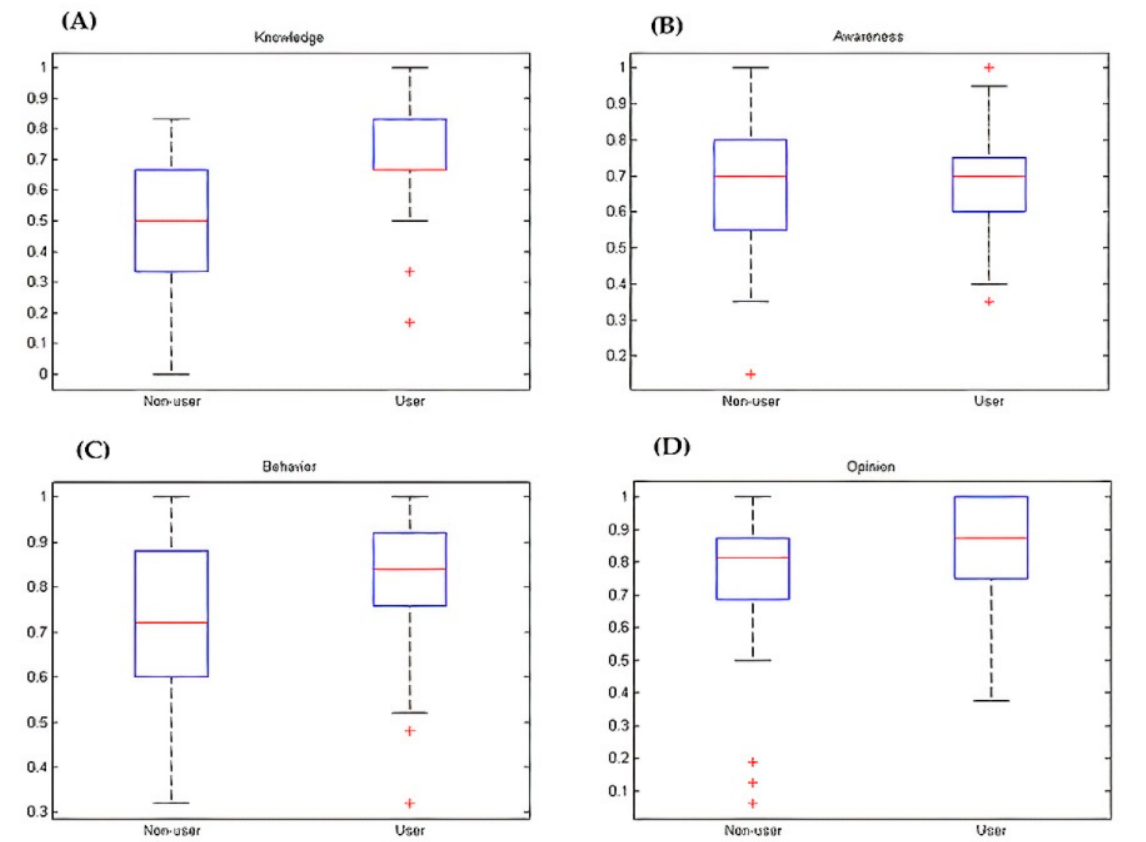
Figure 3. Boxplot of variables ( A ) “Knowledge, ( B ) “Awareness”, ( C ) “Behavior”, and ( D ) “Opinion” between laboratory and non-laboratory user.